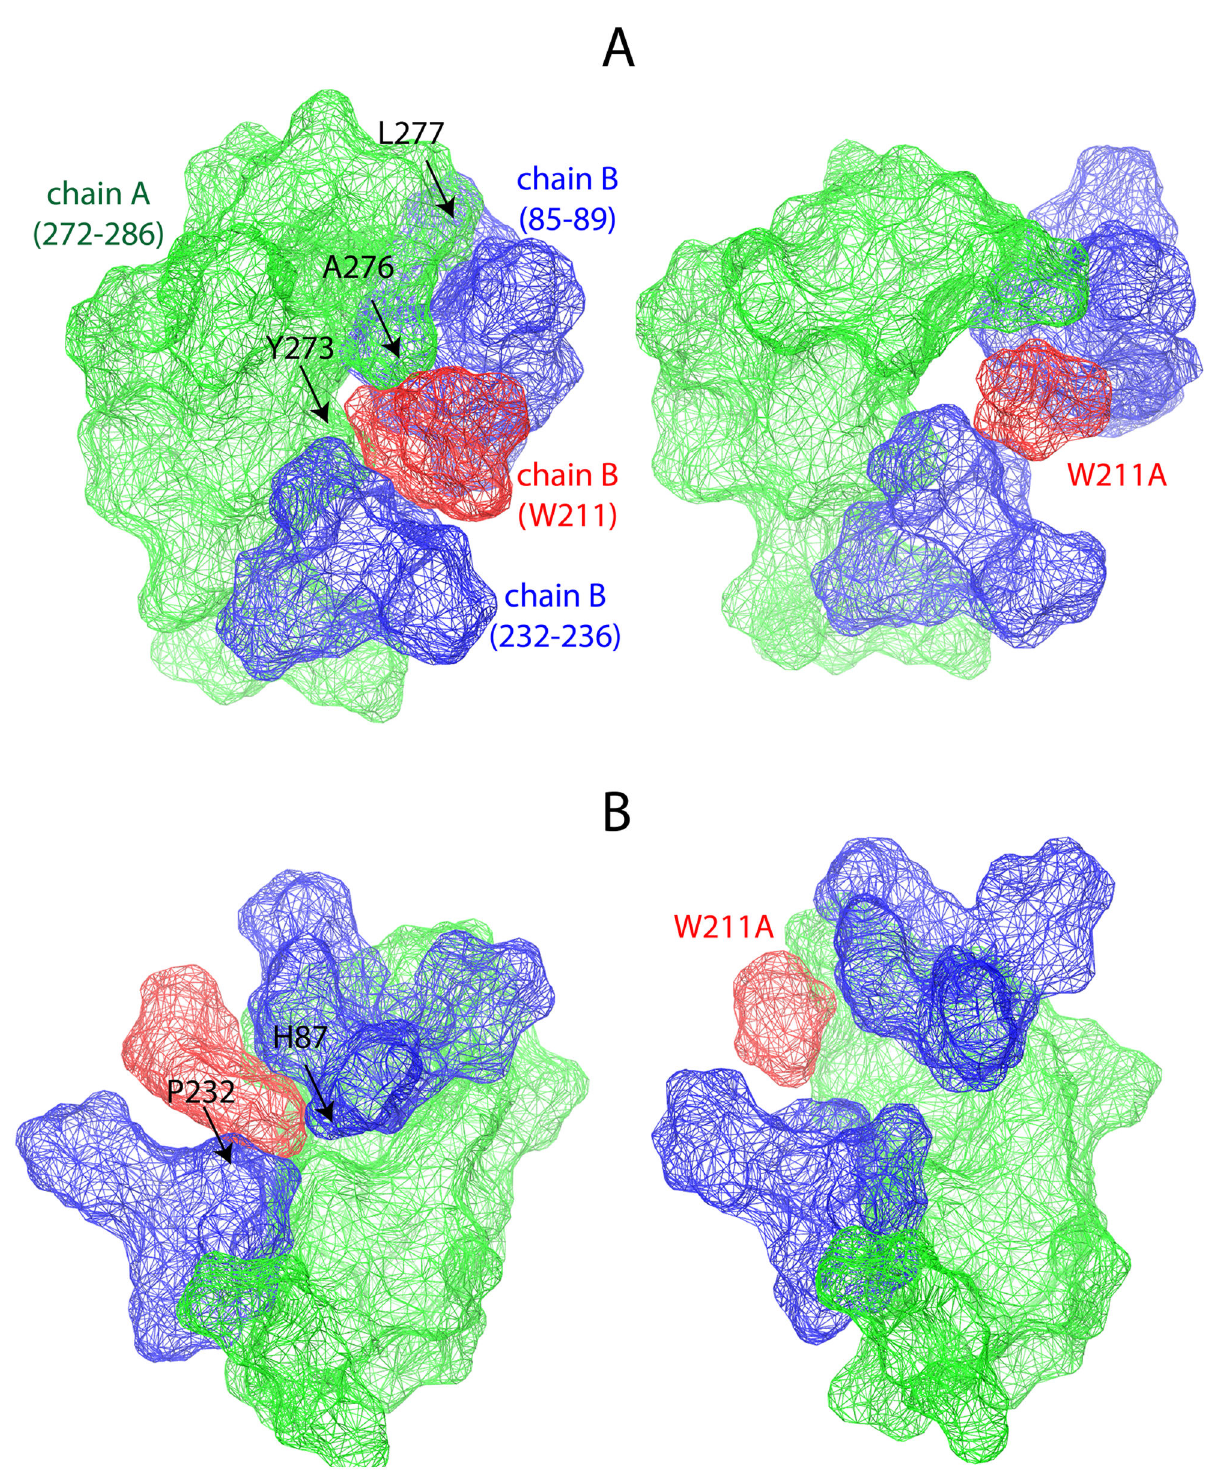
Figure 6. The structural impact of W211A mutation on the subunit interface. The subunit interface is rendered by van der Waals surface using the colors; green for chain A, blue for chain B, and red for 211 (W or A) that is found in chain B. The arrows indicate the residues that change conformation upon W211A mutation in (A) chain A and (B) chain B. The representation in (A) has been rotated 180° around the left diagonal axis to obtain (B), and the snapshots were taken from the simulations performed at 75°C.